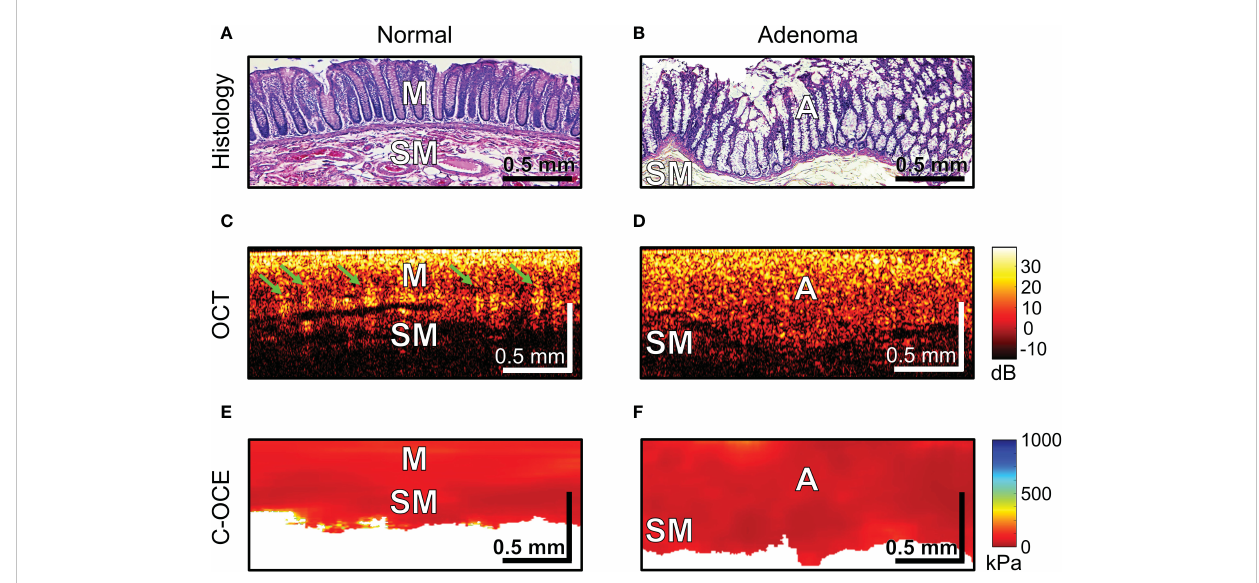
FIGURE 4 Examples of morphological examination of normal colon (A, C, E) and colorectal adenoma (B, D, F) tissues by C-OCE: low stiffness values of mucosa [M] (58 ± 28 kPa) and submucosa [SM] (43 ± 17 kPa) did not statistically signi fi cantly differ from stiffness values of benign adenoma [A] (46 ± 22 kPa). Corresponding tissue areas in histological (A, B) , OCT (C, D) and C-O С E (E, F) images. Bar size is shown in the images.